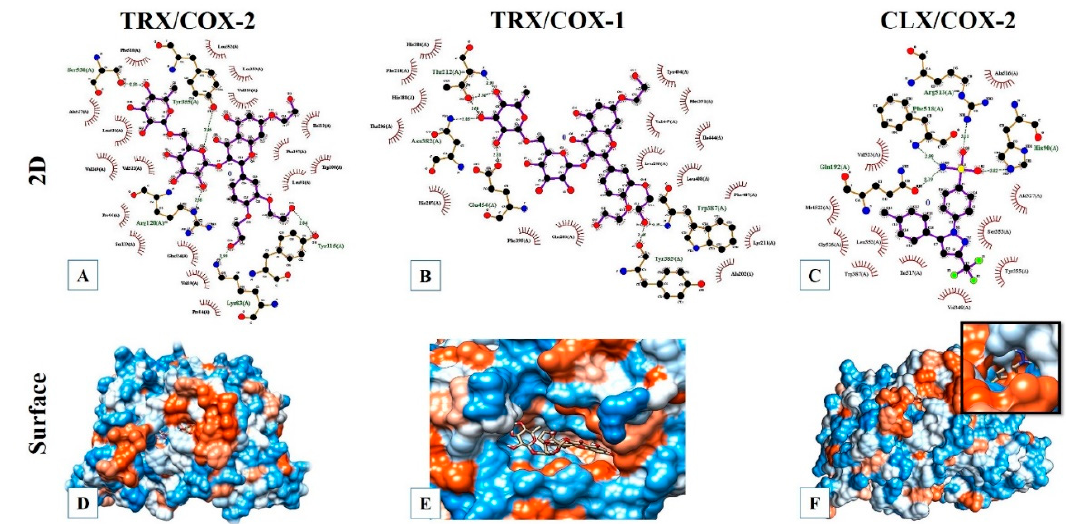
Figure 9. Molecular docking models of TRX or CLX with COX-1 and COX-2. ( A ), ( B ), and ( C ): Ligplot 2D diagrams showing details of hydrogen bond and hydrophobic interactions in complexes TRX / COX-2, TRX / COX-1, and CLX / COX-2, respectively. ( D ), ( E ), and ( F ): Surface docking poses of TRX/COX-2, TRX/COX-1, and CLX/COX-2, respectively.